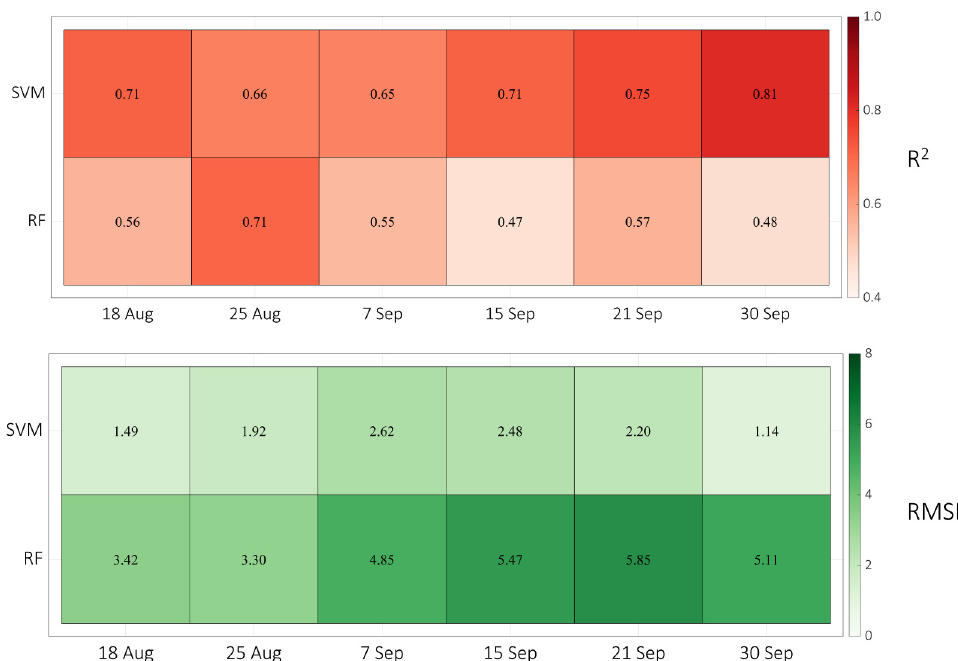
Figure 8. The validation of the support vector machine (SVM) and random forest (RF) methods at different growth stages of maize. Note: Aug represents August, and Sep represents September, respectively.